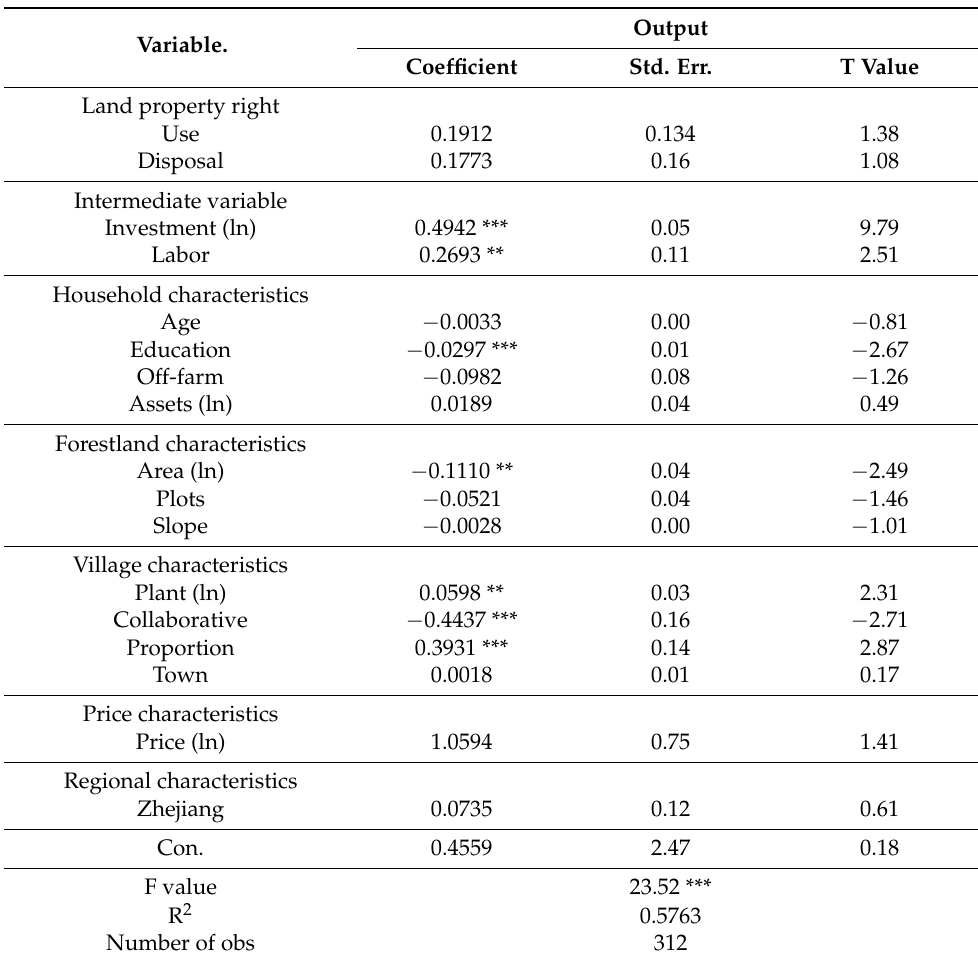
Table 3. Estimate results of land property right on forest output.